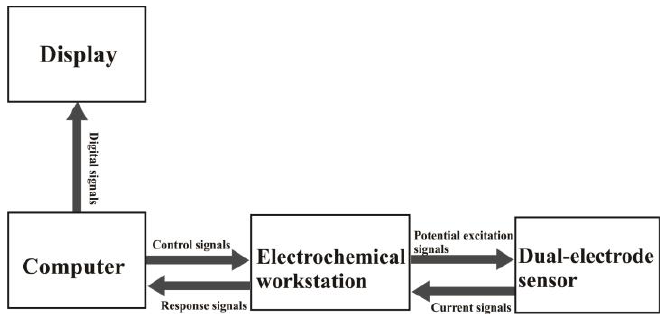
Figure 1. Schematic of the sensor system.